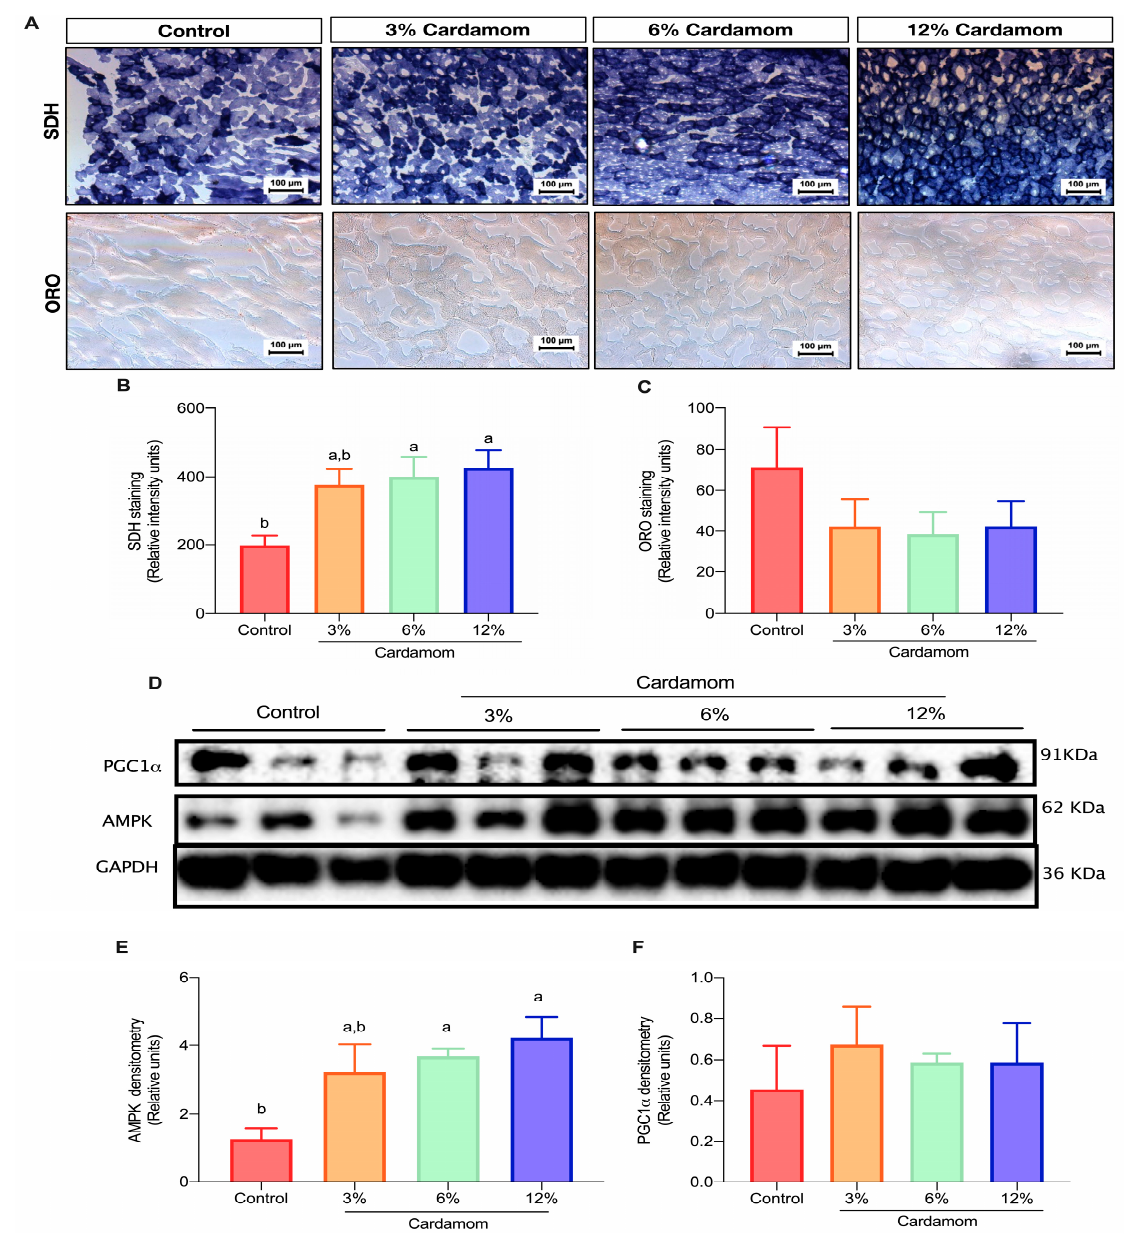
Figure 4. Skeletal muscle mitochondrial activity, lipid content, PGC1 α and AMPK protein density of mice fed a control diet or a diet containing 3%, 6% or 12% of Elettaria cardamomum (EC). ( A ) representative photomicrographs of succinate dehydrogenase (SDH) and oil red O (ORO) staining in the skeletal muscle; ( B ) SDH staining densitometric analysis; ( C ) ORO staining densitometric analysis; ( D ) representative image of PGC-1 α and AMPK immunoblot; ( E ) densitometric analysis of AMPK/GADPH protein abundance ratio; and ( F ) densitometric analysis of PGC1 α /GADPH protein abundance ratio of mice fed a control diet or diets containing 3%, 6% or 12% EC. Results are presented as the mean ± S.E.M., n = 8 mice per group. The differences were considered statistically significant when p < 0.05. Mean values with different lowercase letters show statistical differences between each other. Digital photographs were taken from each section at 20×.